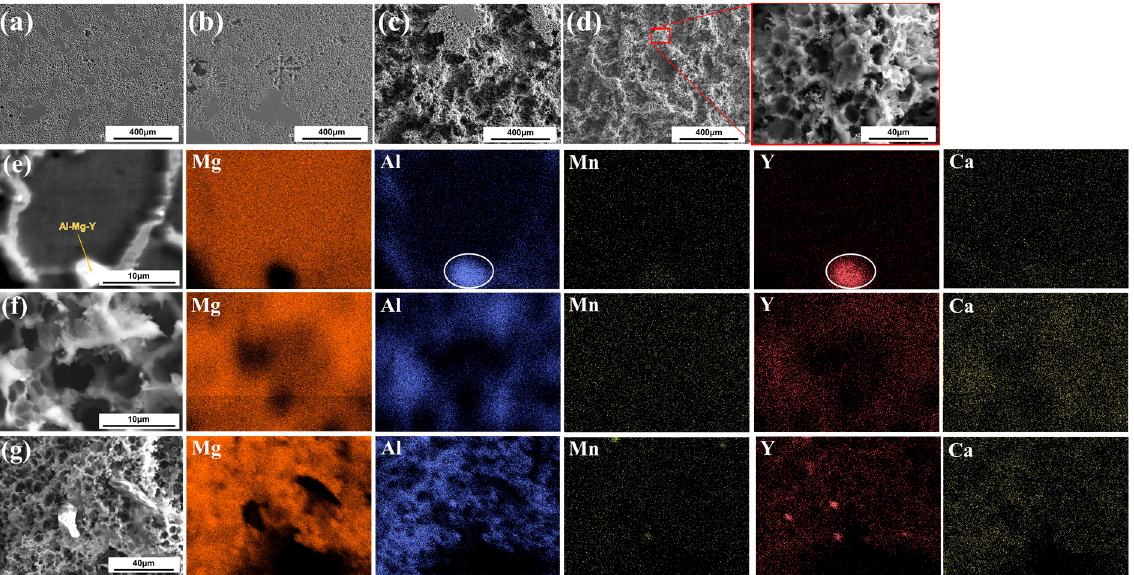
Figure 5. SEM images of HPDCed AMXW6000 alloy under various immersion time: ( a ) 3 h; ( b ) 12 h; ( c ) 2 days; ( d ) 8 days; SEM with EDS mapping of HPDCed AM6000 alloy after immersion for ( e ) 12 h; ( f ) 2 d; ( g ) 8 d, respectively.